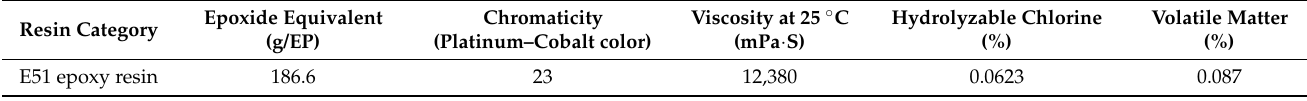
Table 1. Material properties of non-solvent E51 (618) epoxy resin.